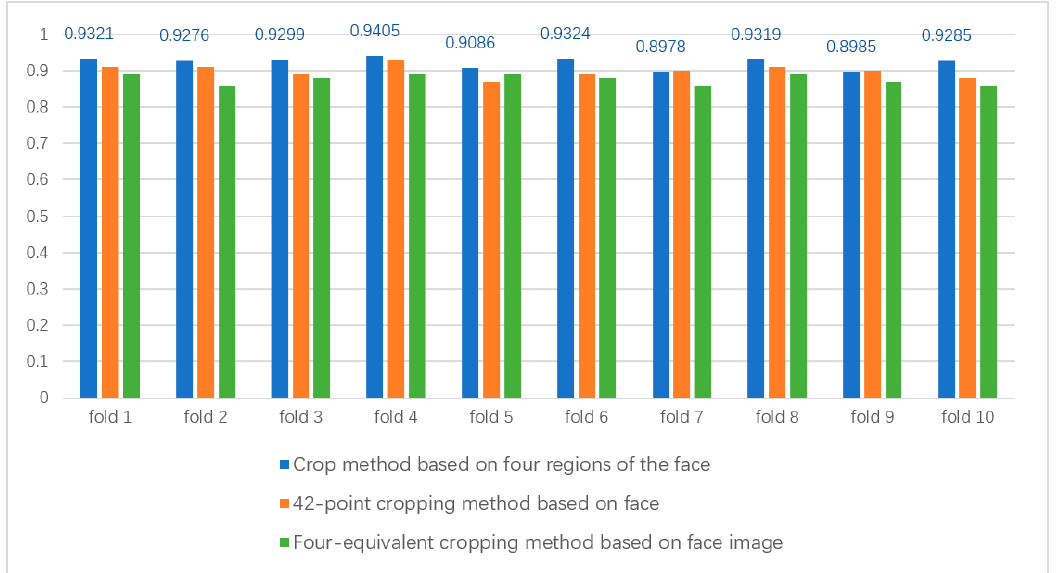
Figure 7. Accuracy (%) of 10-fold on the CK+ validation set using three facial region segmentation methods.